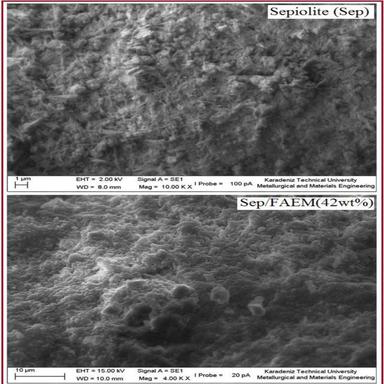
SEM photographs of (a) Sep (b)Sep/FAEM(42 wt%).